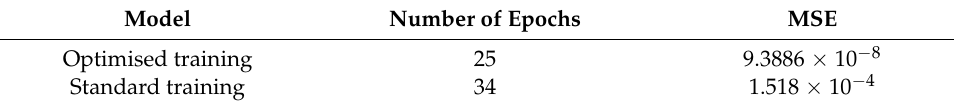
Table 4. A training strategy for on optimised ANN VS conventional ANN.